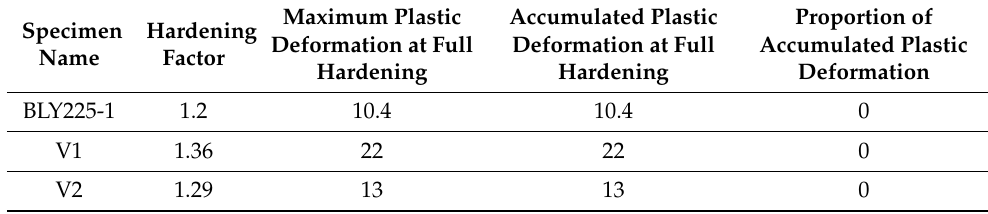
Table 3. Input BRB hardening